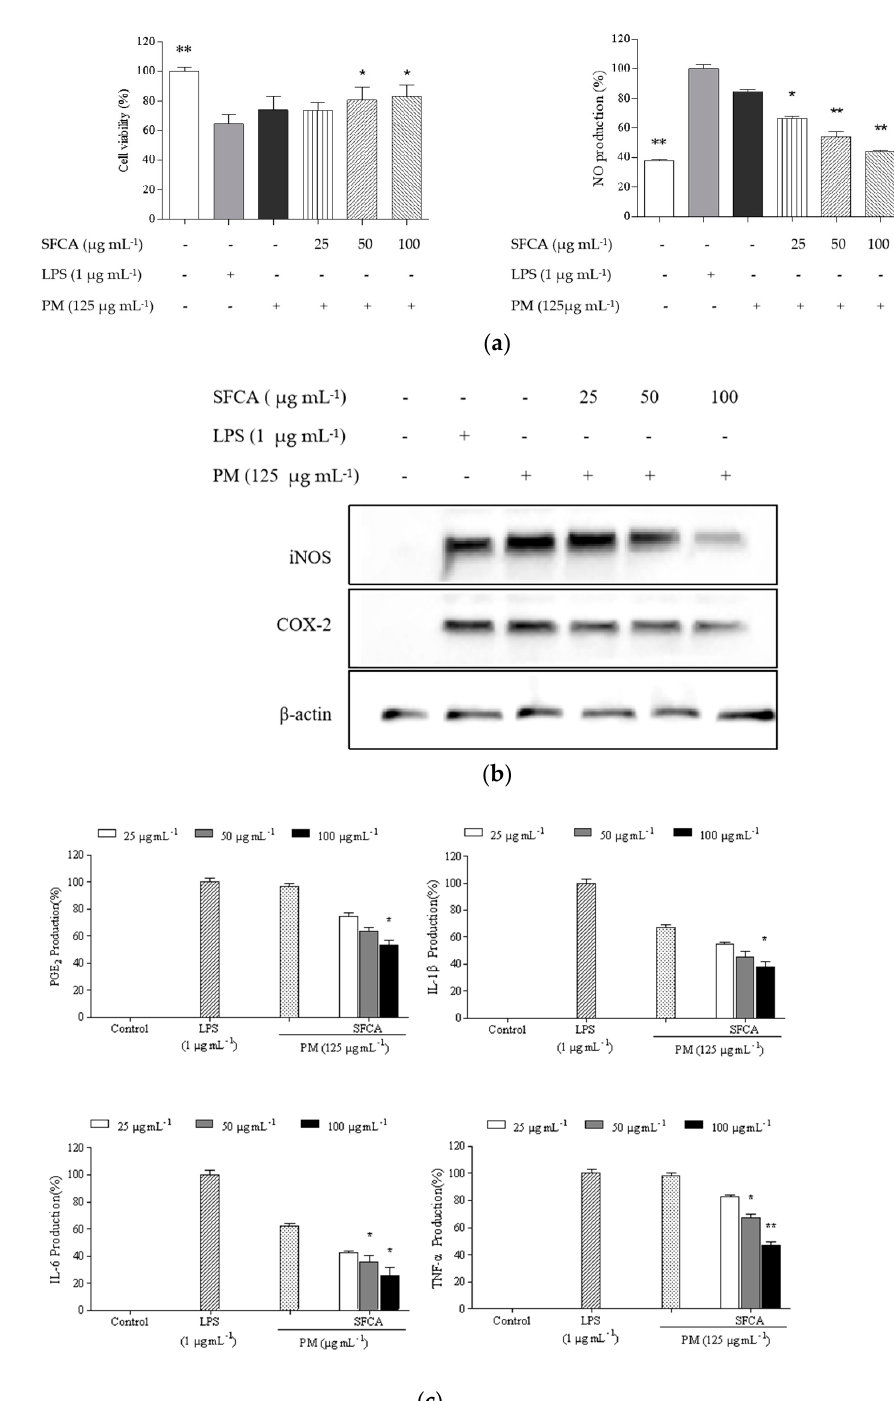
Figure 3. Efficacy of SFCA against inflammation induced by PM in RAW 264.7 macrophages ( a ), and analyses of RAW cell viability and intracellular ROS levels; ( b ) Western blot analyses of iNOS and COX-2 expressions; and ( c ) ELISA of PGE 2 and pro-inflammatory cytokines (IL-1 β , IL-6, and TNF- α ). Pre-seeded cells (1 × 10 5 cells mL − 1 ) were treated with or without different SFCA concentrations after 24 h and stimulated with PM after 30 min. Cells were harvested after 24 h to measure inflammatory mediators (COX-2 and PGE 2 ) and pro-inflammatory cytokines (IL-1 β , IL-6, and TNF- α ). Graphical representations are means ± SE based on three replications. * p < 0.05 and ** p < 0.01 indicate that values were significantly different from those for the PM-treated group.